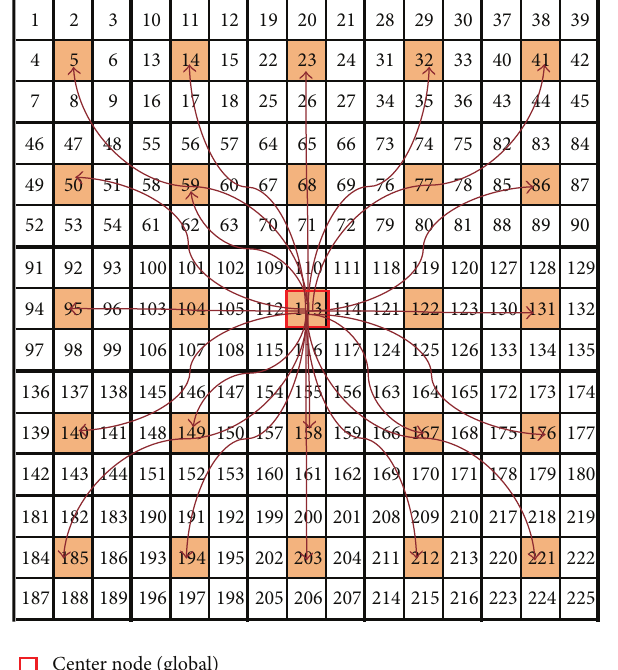
Figure 7: Smallest Small World harmony search network.